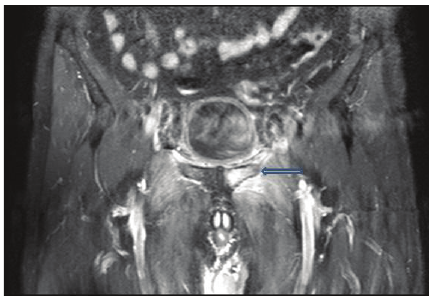
Figure 2: Pelvic MRI demonstrated inflammatory change in left pubic bone (arrow) and adductor muscle.